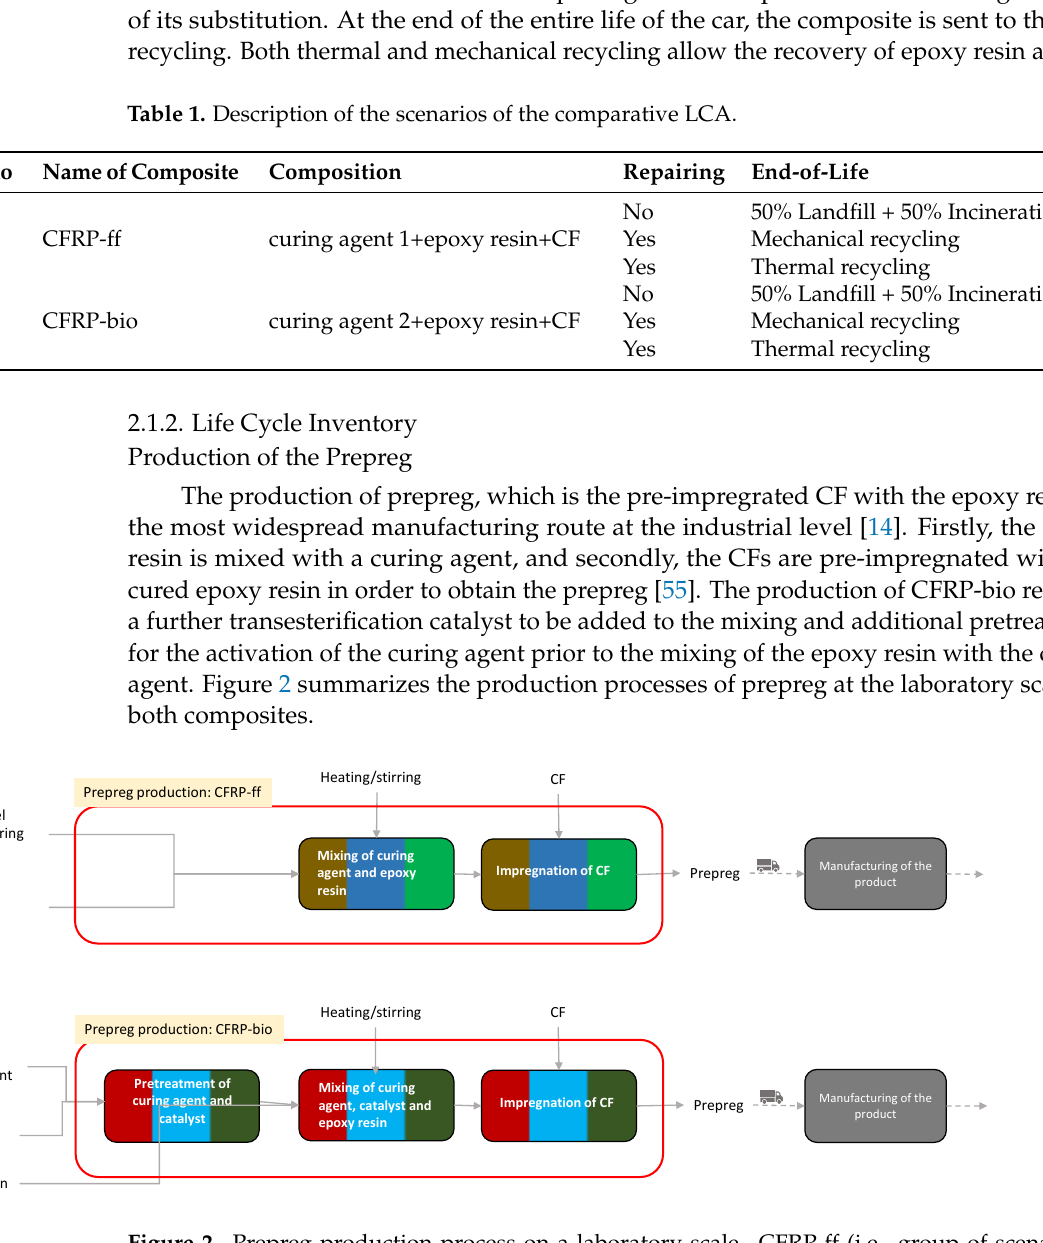
Figure 2. Prepreg production process on a laboratory scale. CFRP-ff (i.e., group of scenario A) includes two main steps: firstly, mixing the dynamic curing agent with the epoxy resin, and secondly, the impregnation of the CF. CFRP-bio (i.e., group of scenario B) includes the same steps of scenario A plus two additional pretreatment steps needed for the dynamic curing agent and catalyst. Colors represent the different